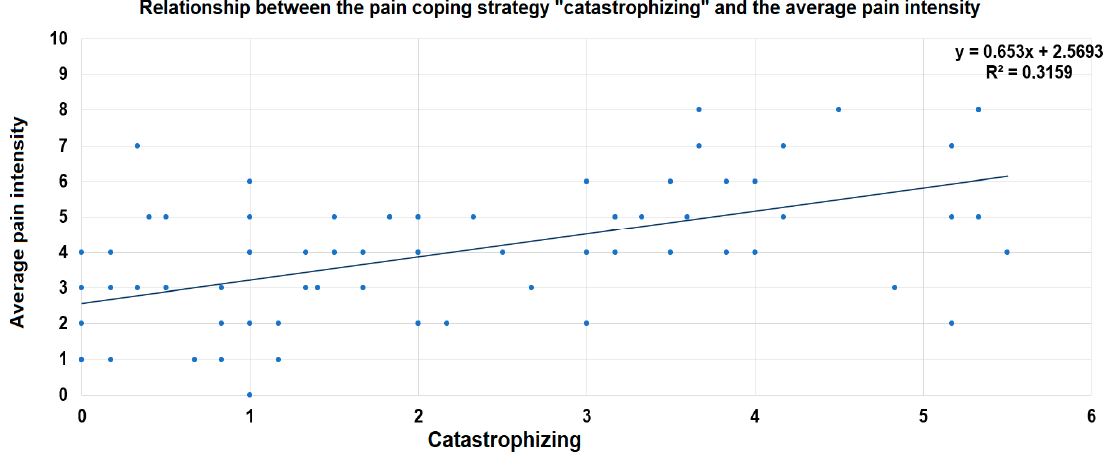
Figure 3. Scatter plot of the relationship between the CSQ subscale score for “catastrophizing” and the average pain intensity ratings according to the BPI. A linear regression line has been superim ‐ posed.